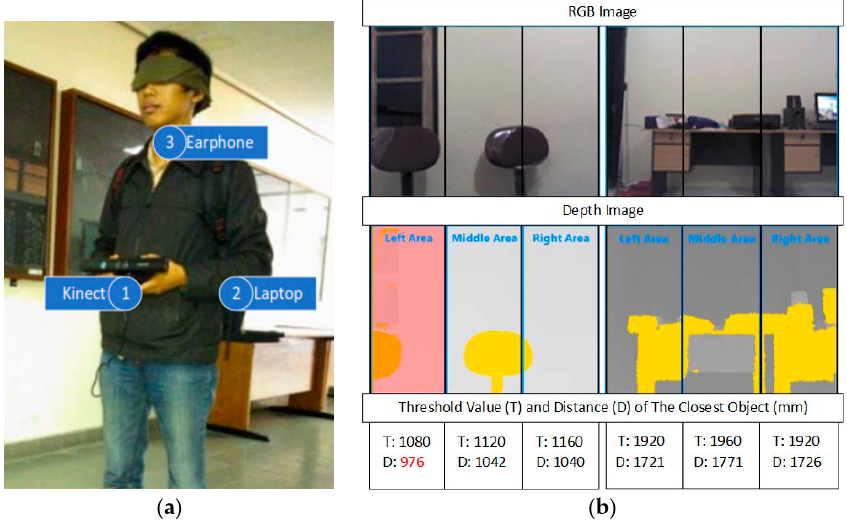
Figure 19. ( a ) The prototype of the proposed system; ( b ) calculating threshold value and the distance of the closest object [39].